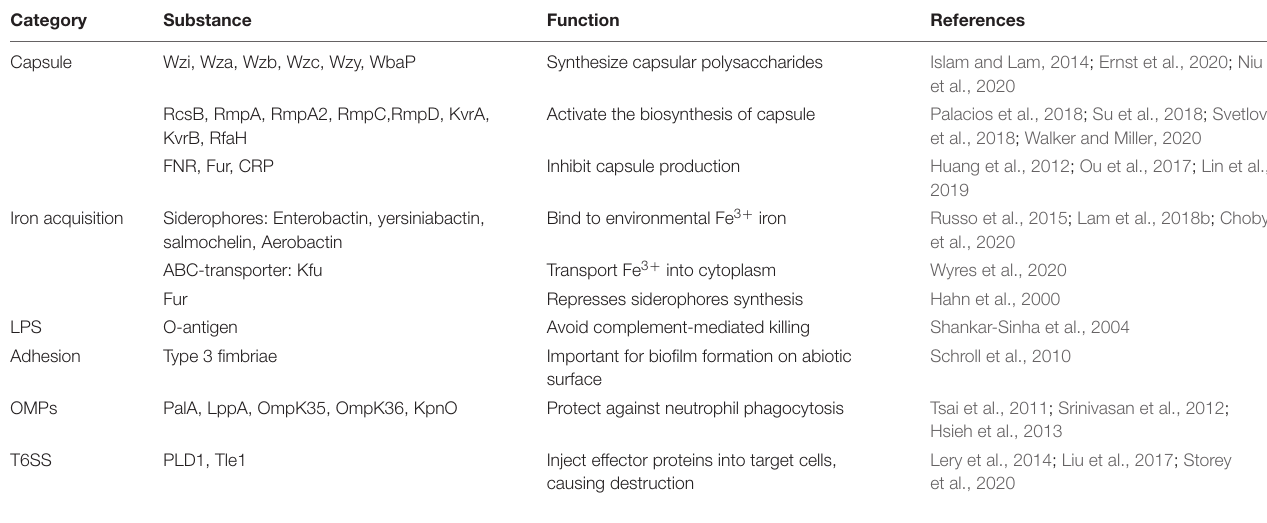
TABLE 2 | Summary of virulence factors of hypervirulent K.